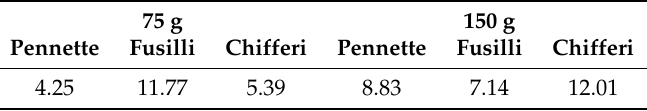
Table 3. Standard deviation of the calculated volumes.